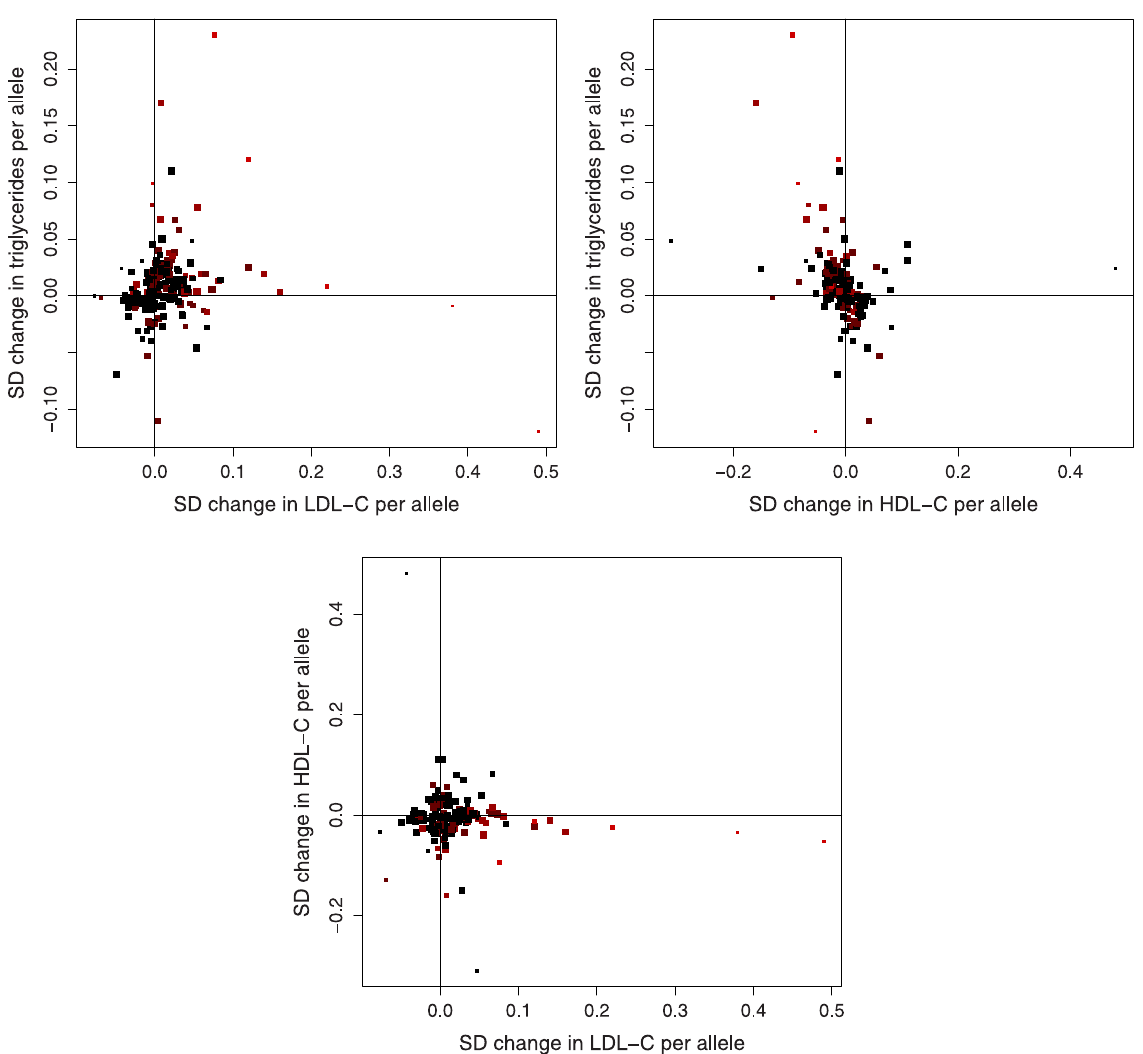
Figure 1. Associations of lipid-related genetic variants with lipid fractions. Association of coronary artery disease (CAD) risk-increasing alleles of 185 genetic variants with all pairs of low-density lipoprotein cholesterol (LDL-c), high-density lipoprotein cholesterol (HDL-c), and triglycerides (brightness and size of points: brighter points correspond to stronger associations with CAD risk, larger points correspond to more precise estimates). Note that some points are overlapping.